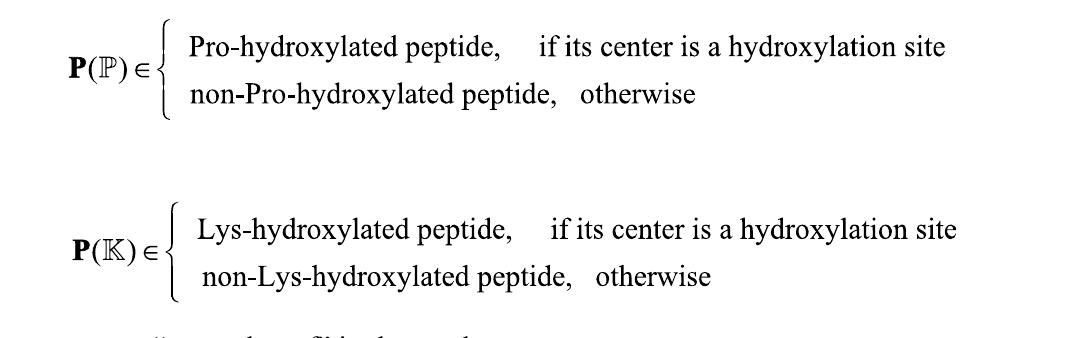
Figure 2. An illustration to show Chou’s scheme for peptides with (2 residues